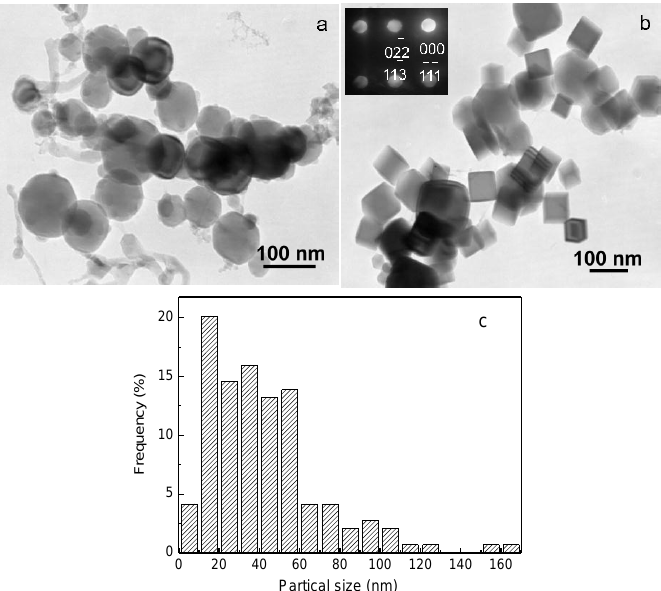
Figure 1. ( a ) and ( b ) Typical bright-field transmission electron microscope (TEM) micrographs of the nanoparticles synthesized from the master alloy of Ti–48Al by hydrogen plasma-metal reaction (HPMR) in N 2 , H 2 , and Ar atmosphere; ( c ) particle size distribution.